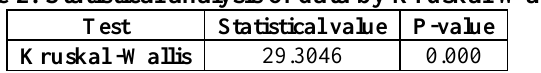
Table 2: Statistical analysis of data by Kruskal-Wallis